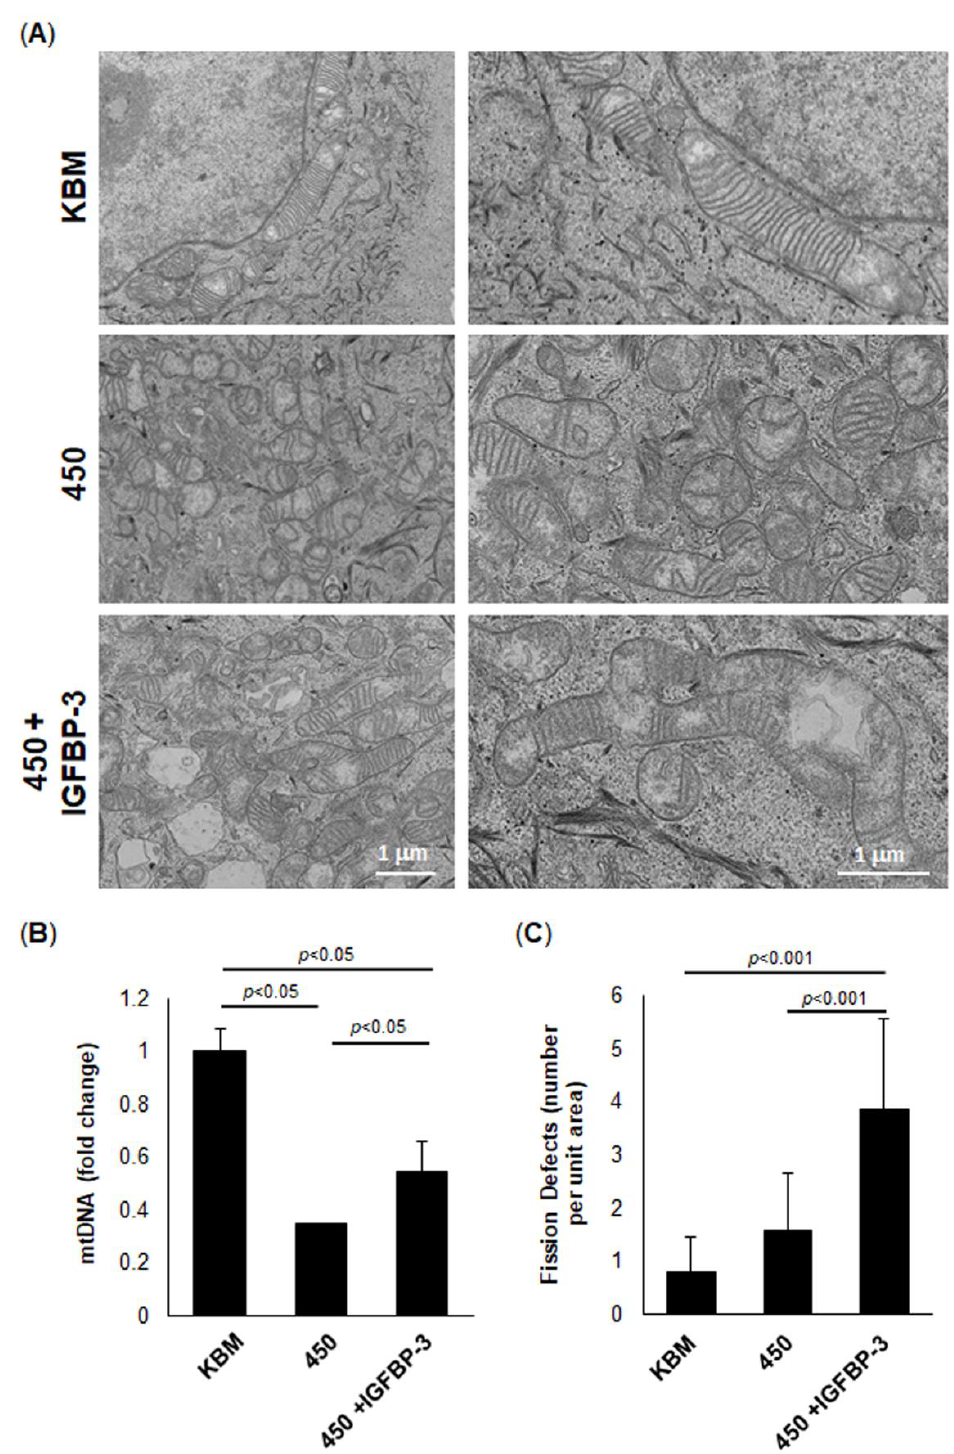
Figure 5. IGFBP-3 induces fission defects in mitochondria exposed to hyperosmolar stress. Cells were cultured in KBM or 450 mOsm KBM with or without 500 ng/mL rhIGFBP-3 for 24 h. ( A ) Transmission electron microscopy was performed to assess mitochondrial ultrastructure. Scale bar: 1 μm. ( B ) mtDNA was quantified using qPCR. Hyperosmolar stress decreased mtDNA ( p < 0.05), whereas co-treatment with rhIGFBP-3 partially restored mtDNA to basal levels. ( C ) Quantification of fis-